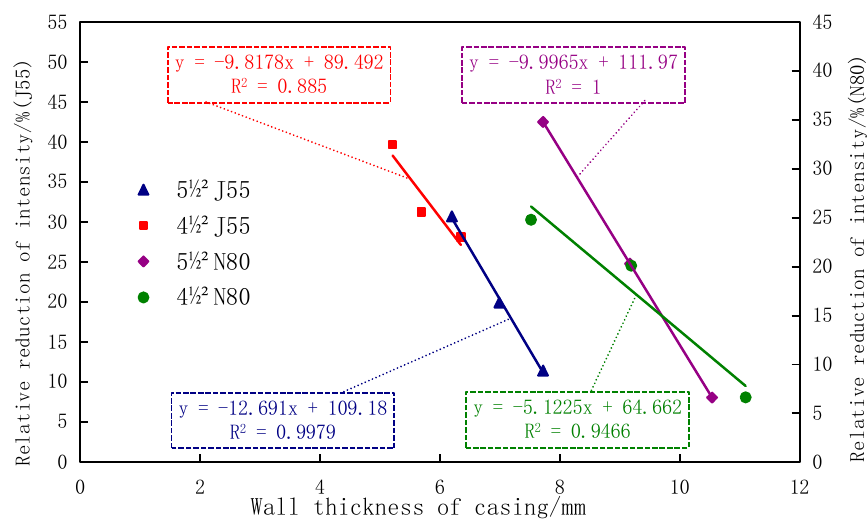
Figure 16. Relationship between relative intensity-reduction ratio and casing wall thickness.